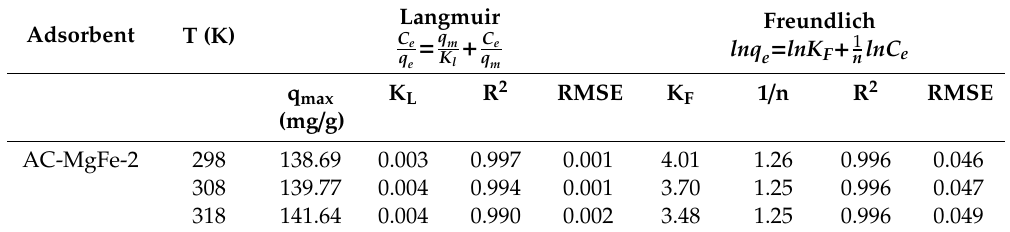
Figure 7. Linear isotherm models ( a ) Langmuir and ( b ) Freundlich and ( c ) R L phenol removal onto AC–MgFe-2 composite and ( d ) plot of Ln Kd vs. 1 / T for estimation of the thermodynamic parameters. Table 3. Parameters of linear Langmuir and Freundlich isotherm models for phenol adsorption onto AC–MgFe-2 composites.